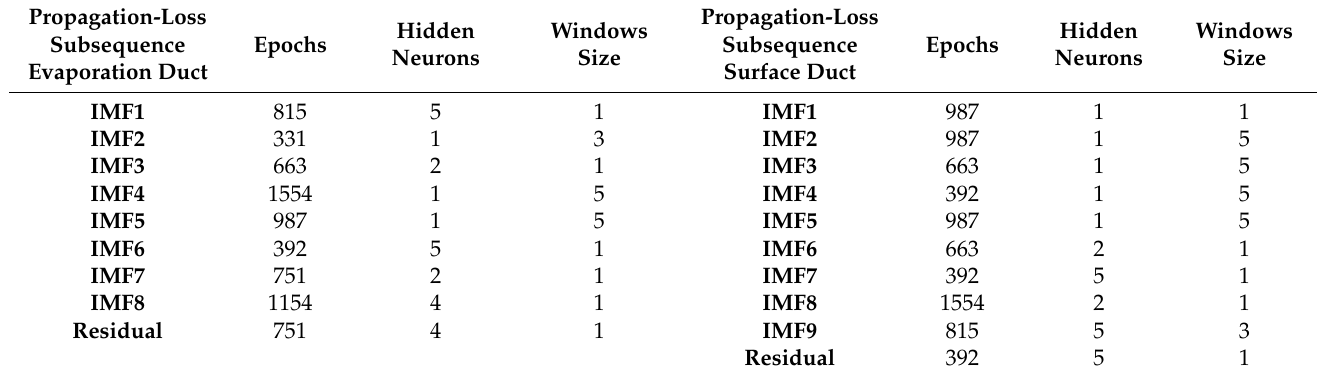
Table 1. Result of hyperparameter optimization based on the genetic algorithm (GA).